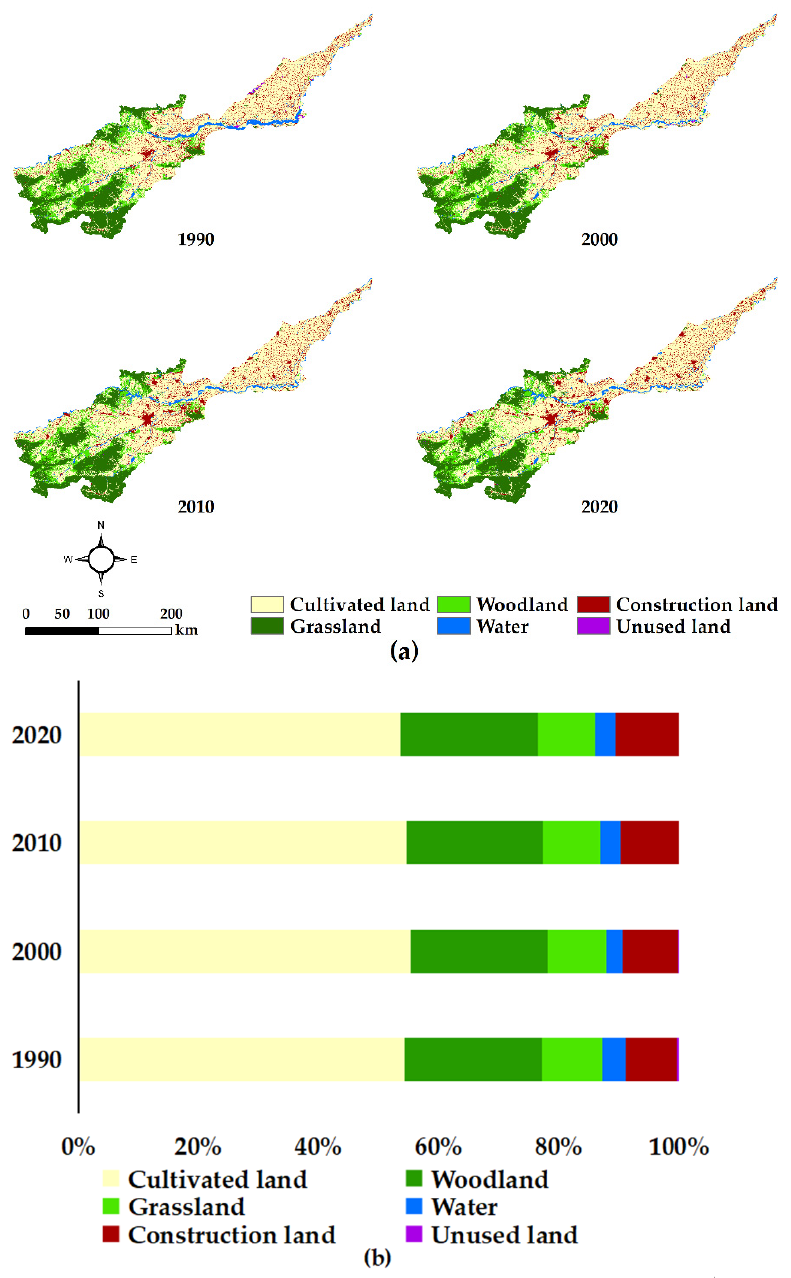
Figure 3. The types of land use in the Yellow River Basin (Henan section) (1990–2020): ( a ) spatial distribution of land use; ( b ) percent coverage of the land use types.